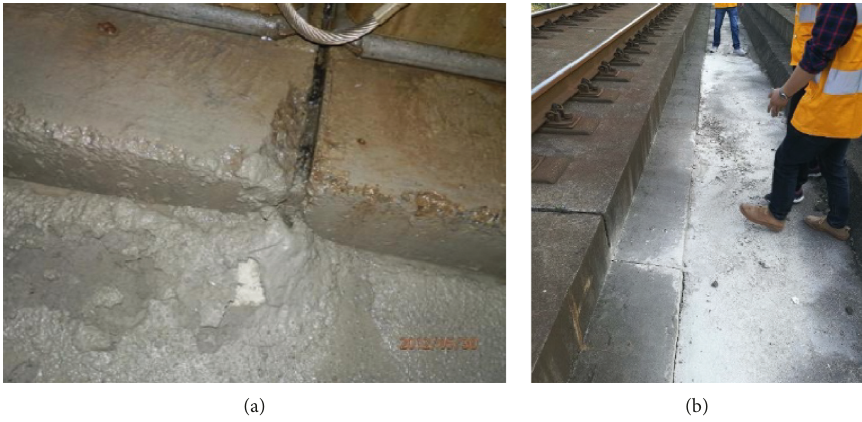
Figure 1: Mud pumping occurring in the ballastless track-subgrade during